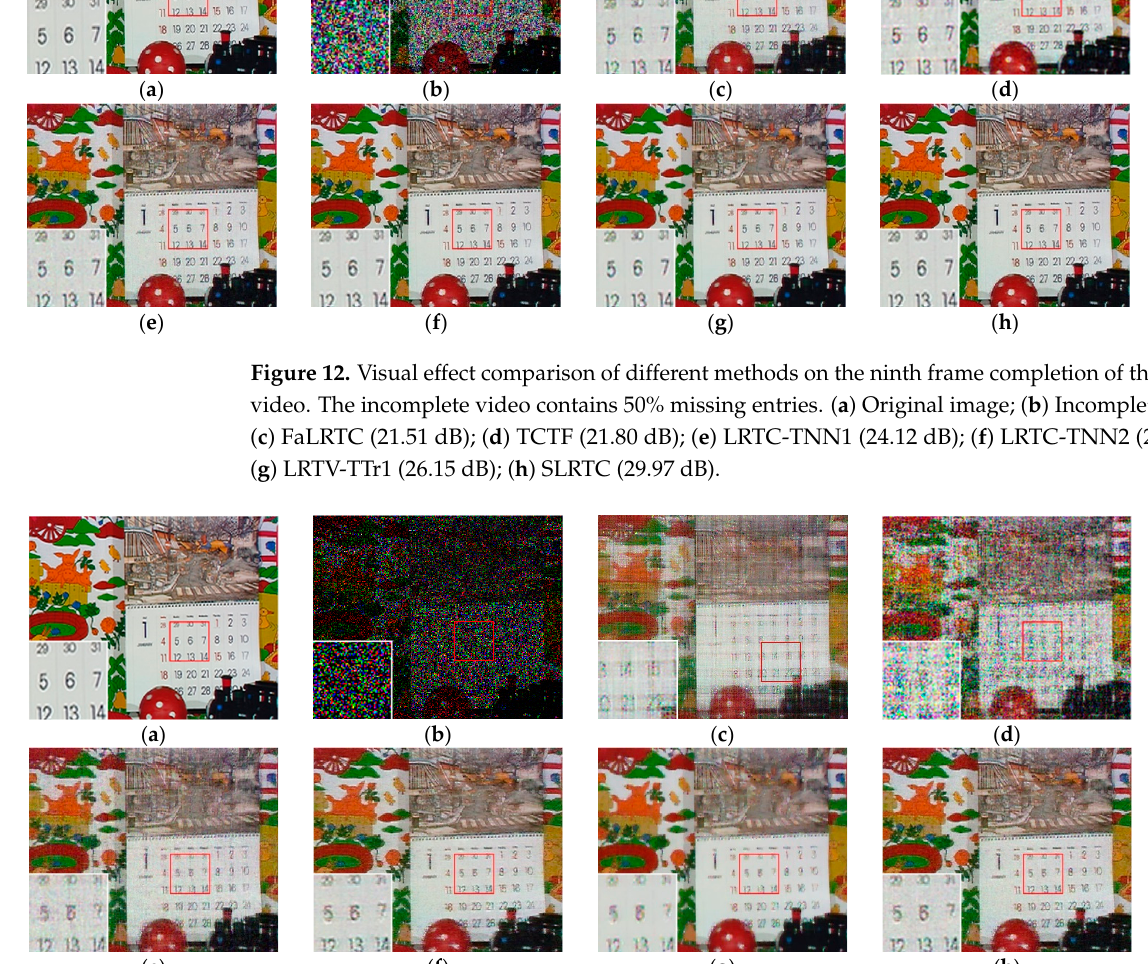
Figure 13. Visual effect comparison of different methods on the ninth frame completion of the Mo-